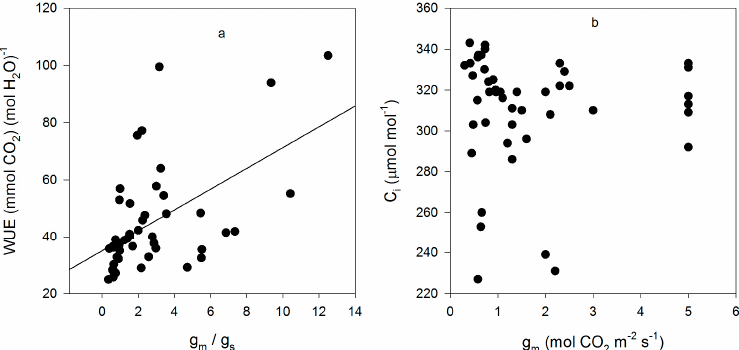
Figure 4. Relationships between the ratio of g m to g s and WUE ( a ); and between g m and C i ( b ) for all measurements made on fifteen cultivars of soybean. The correlation between the g m to g s ratio and WUE had an r value of +0.53, and that between g m and C i was +0.116, which was not significant at p = 0.05.